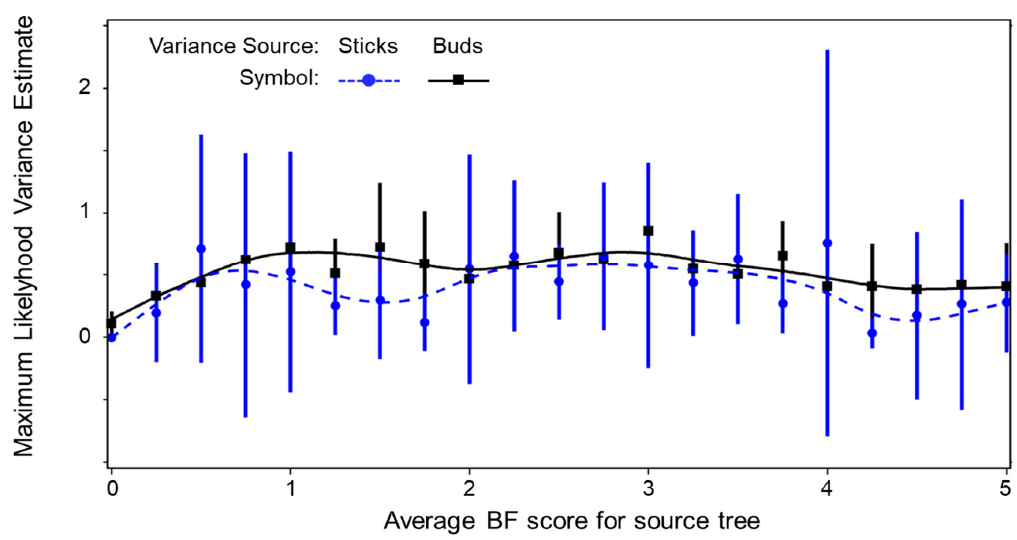
Figure 1. Variance due to sticks and buds of ‘Carmel’ almond as estimated by analyzing each propagation source tree, assuming that the error term would largely represent variation due to buds, and where average BF (noninfectious bud- failure) score for each propagation source tree is used as a measure of the NBF potential for that propagation source tree. Table 1. Maximum likelihood estimates for the variance components of final noninfectious bud- failure (NBF) in ‘Carmel’ almond expression in the overall dataset.